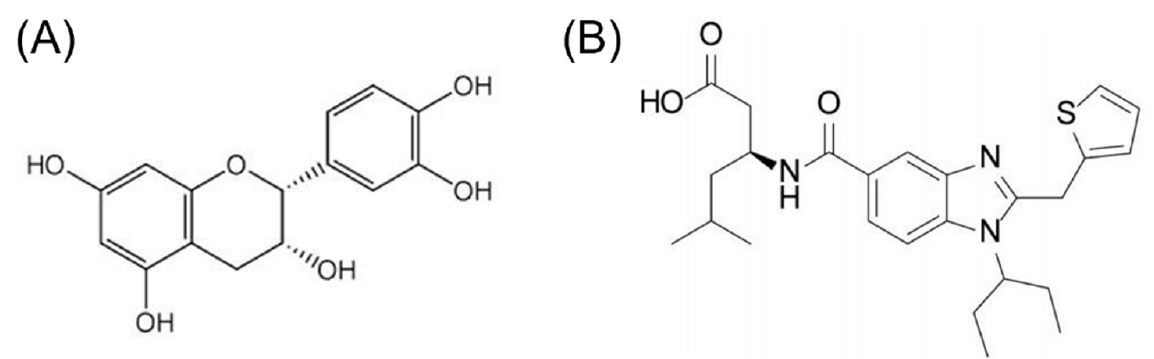
Figure 3. ( A ) ( ‐ ) ‐ Epicatechin and ( B ) CMF ‐ 019 molecular structures. Figure 3. ( A ) (-)-Epicatechin and ( B ) CMF-019 molecular